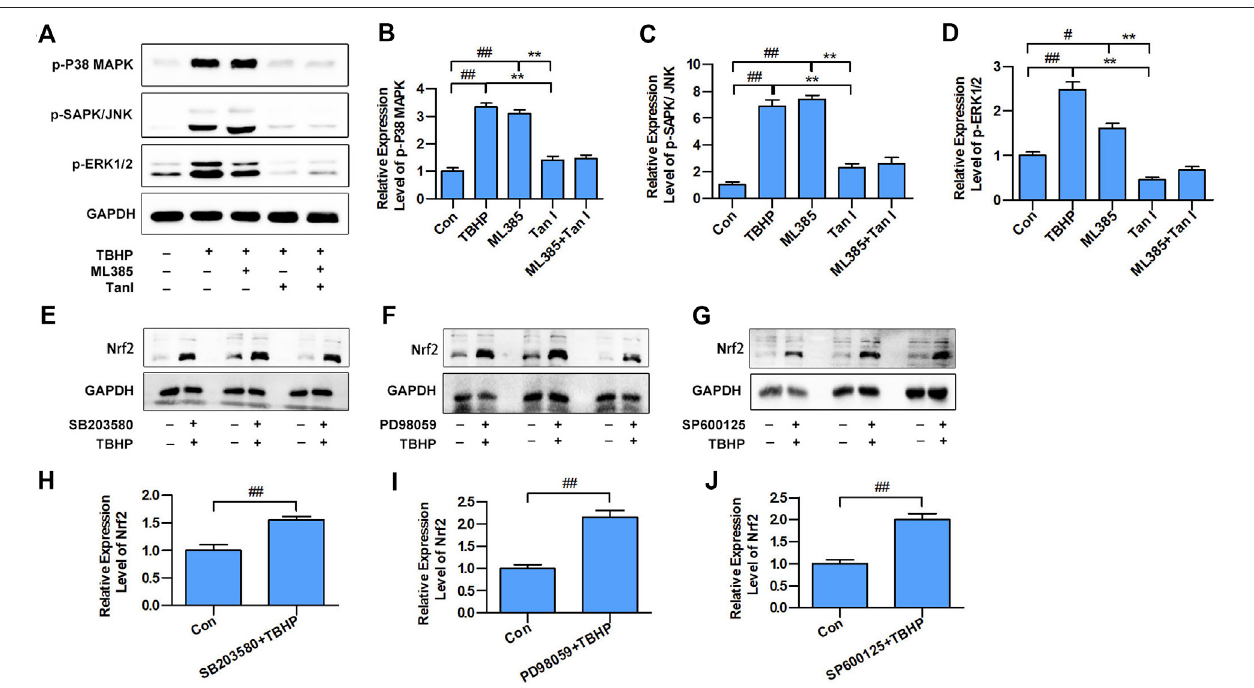
FIGURE 3 | MAPK signaling involved in the Nrf2-mediated oxidative stress – induced cardiomyocyte apoptosis. (A) H9C2 cells incubated with Tan I (2.5 µM) and ML385(10 µM)andthentreatedwithTBHP(200 µM).Expressionlevelsofp-P38MAPK,p-SAPK/JNK,andp-ERK1/2measuredusingWesternblotanalysis( n (cid:2) 3). (B) Relativeexpressionlevelsofp-P38MAPK( n (cid:2) 3). (C) Relativeexpressionlevelsofp-SAPK/JNK ( n (cid:2) 3). (D) Relativeexpressionlevelsofp-ERK1/2( n (cid:2) 3). (E) H9C2cells incubatedwithSB203580(10 µM),thentreatedwithTBHP(200 µM). (F) H9C2cellsincubatedwithPD98059(10 µM),thentreatedwithTBHP(200 µM). (G) H9C2 cells incubated withSP600125(10 µM),then treatedwithTBHP (200 µM). (H – J) Relativeexpression levels ofNrf2( n (cid:2) 3). Dataarepresentedasmean ± S.D. # p < 0.05, ## p < 0.01 , compared to the control group. *p < 0.05, **p < 0.01, compared to the TBHP or ML385